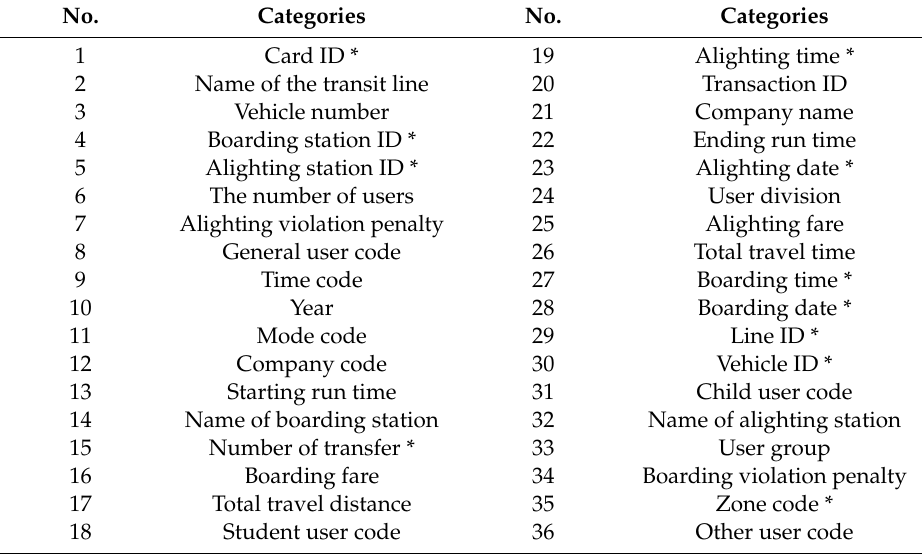
Table 1. Description of the smart card